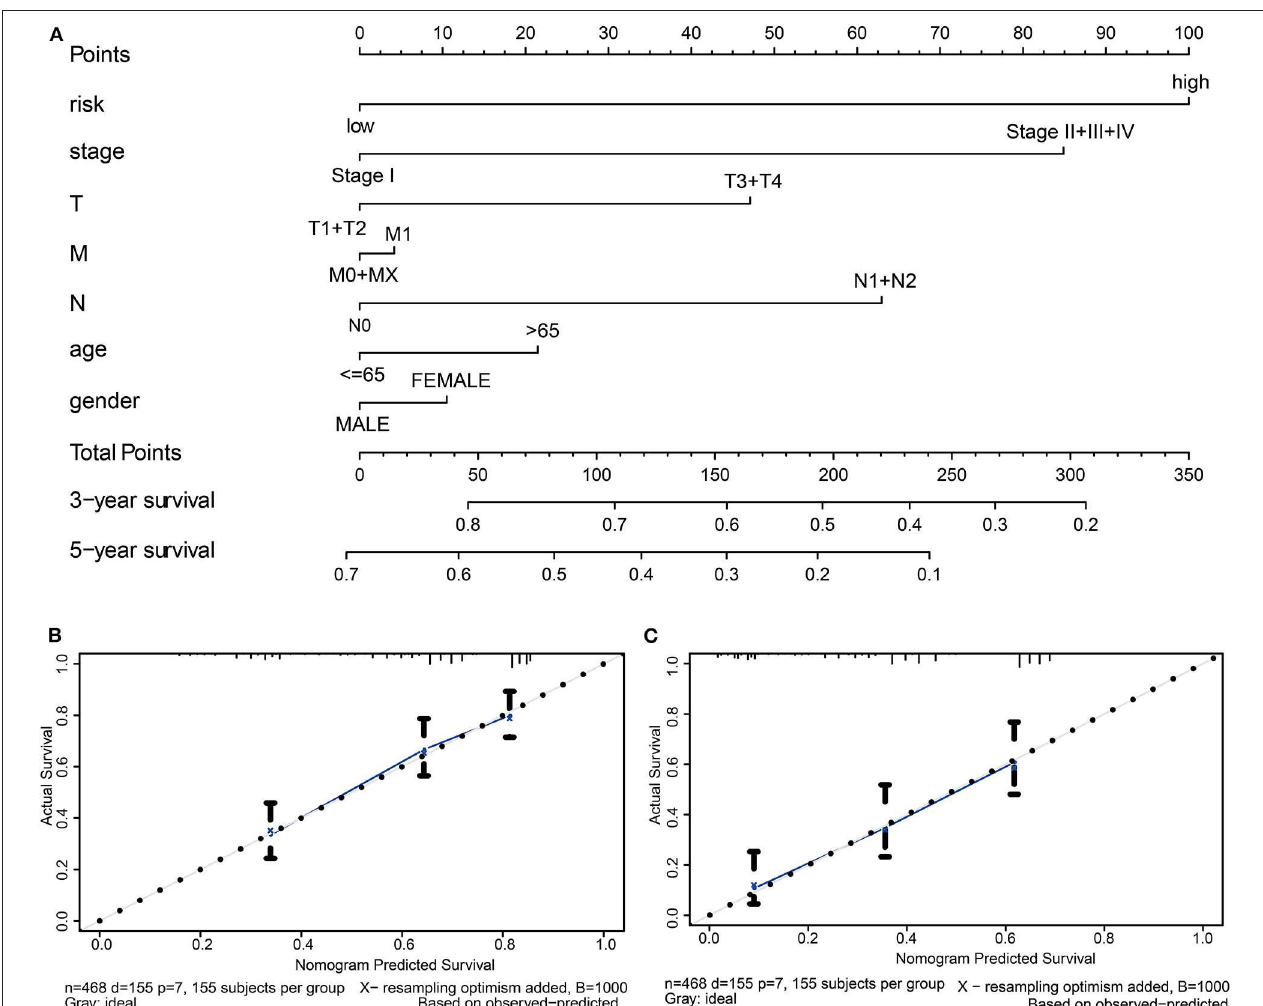
FIGURE 8 | Establishment of the prognostic nomogram in LUAD with the inclusion of the risk score. (A) A nomogram for predicting 3- and 5-year survival possibilities of individual LUAD patients. The calibration curve of 3-year (B) and 5-year survival of LUAD patients (C) . The 45 ◦ dashed line represented a perfect uniformity between nomogram-predicted and real